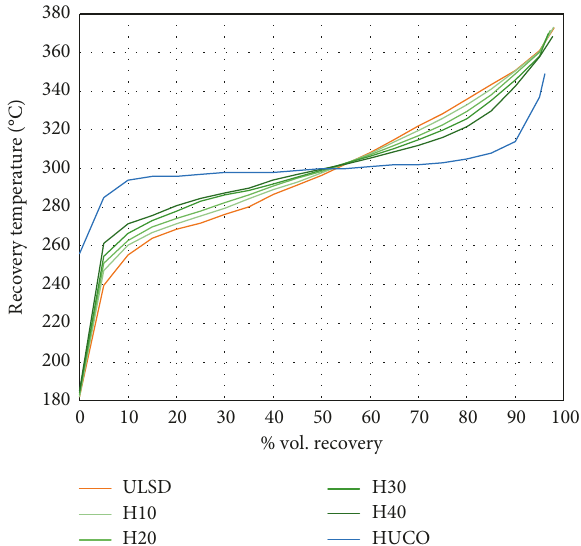
Figure 6: Distillation curves of ULSD, HUCO, and their blends, measured by EN ISO 3405 standard test method.